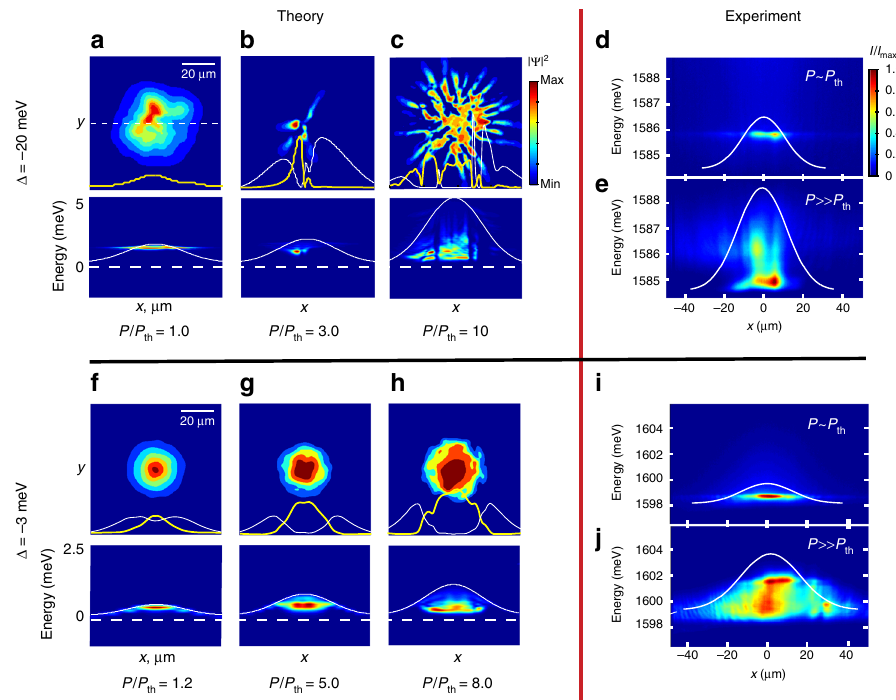
Fig. 5 Theoretical results and spatially resolved energy measurements. a – c , f – h Numerically calculated single-shot real space density and corresponding lifetime-integrated real space spectra E ( x ) near and above the condensation threshold, for a – c highly photonic and f – h more excitonic polaritons. White and yellow curves in the single-shot density plots are the cross-sections of the reservoir ( n R ) and condensate (| ψ | 2 ) densities, respectively. The | ψ | 2 in a is scaled up by a factor of 30, n R is off the scale and is not shown. White solid curves in E ( x ) plots are the initial blue shifts, E R , due to a non-depleted reservoir density n R . Dashed lines correspond to the minimum of the LP dispersion. d , e and i , j Experimentally measured, time-integrated and ensemble-averaged spectra E ( x ) for the ( d , e ) photonic ( Δ = − 20 meV) and i , j more excitonic ( Δ = − 3 meV) polaritons. Panels d , i and e , j correspond to the at and above threshold regimes, respectively, which are similar to the points b and d in Fig. 1(f). White solid curves show non-depleted reservoir density n R deduced